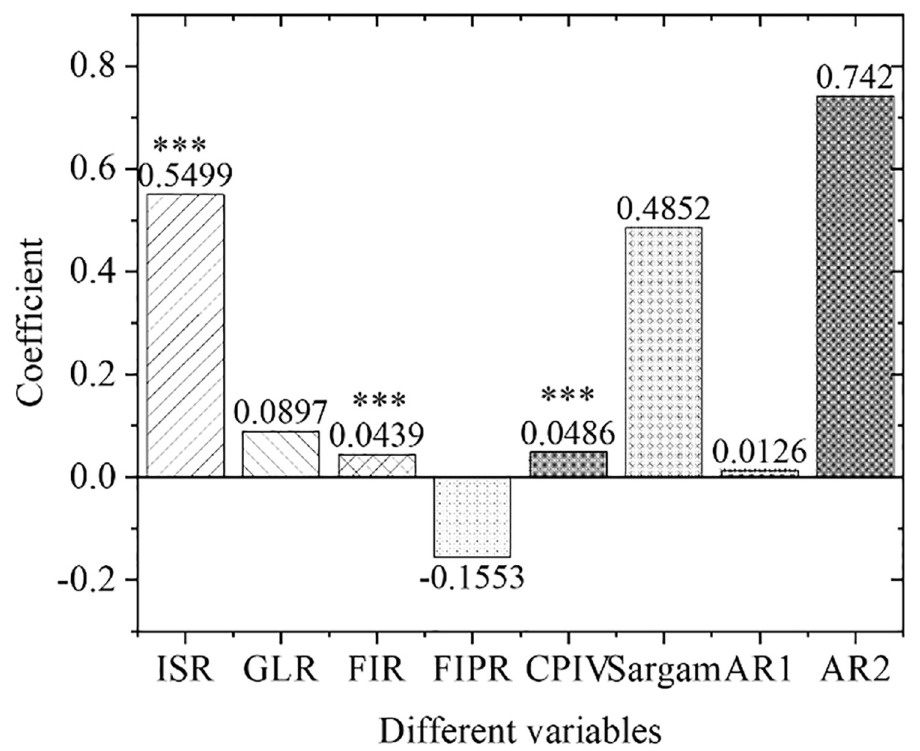
Fig 9. Estimation results of empirical panel coefficients in Central